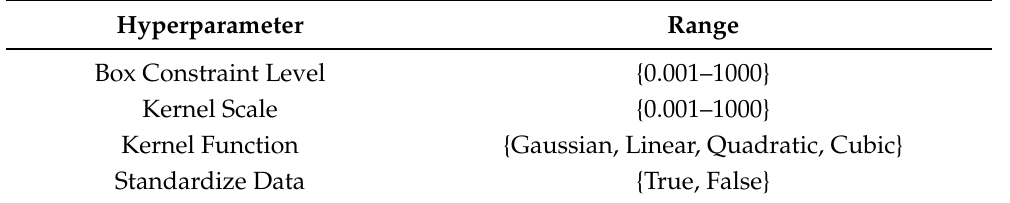
Table 6. Hyperparameter